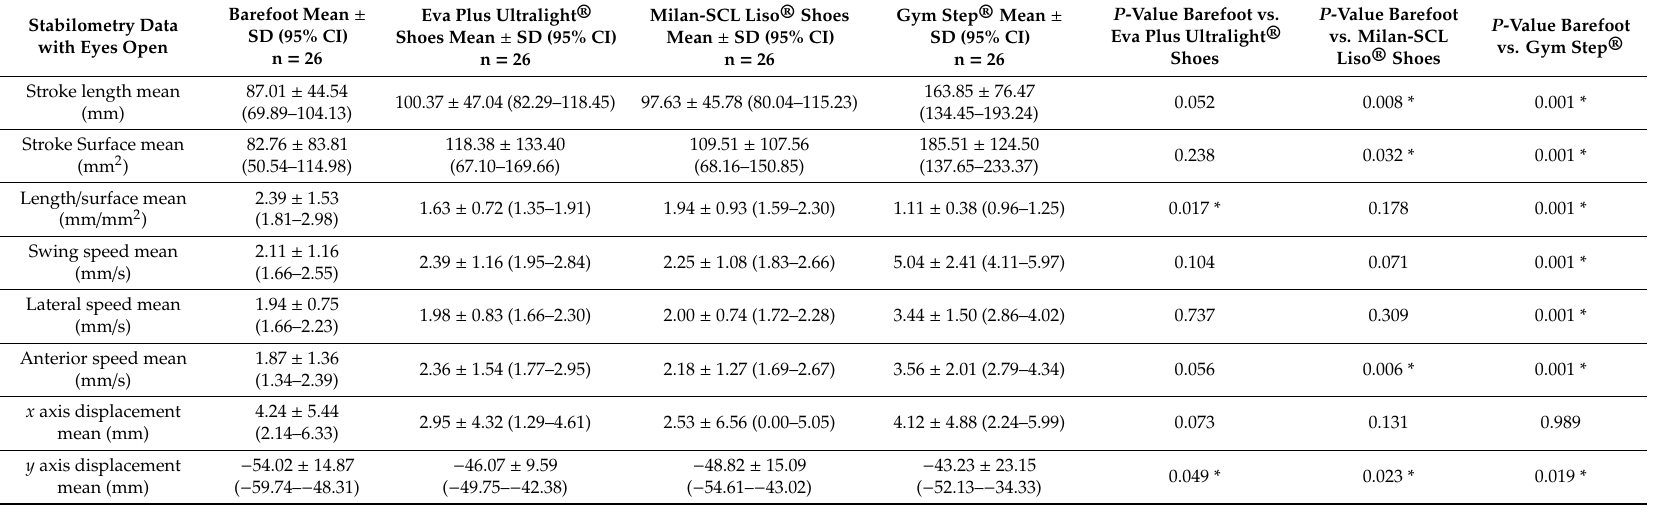
Table 5. Comparison of the stabilometry data with eyes open between